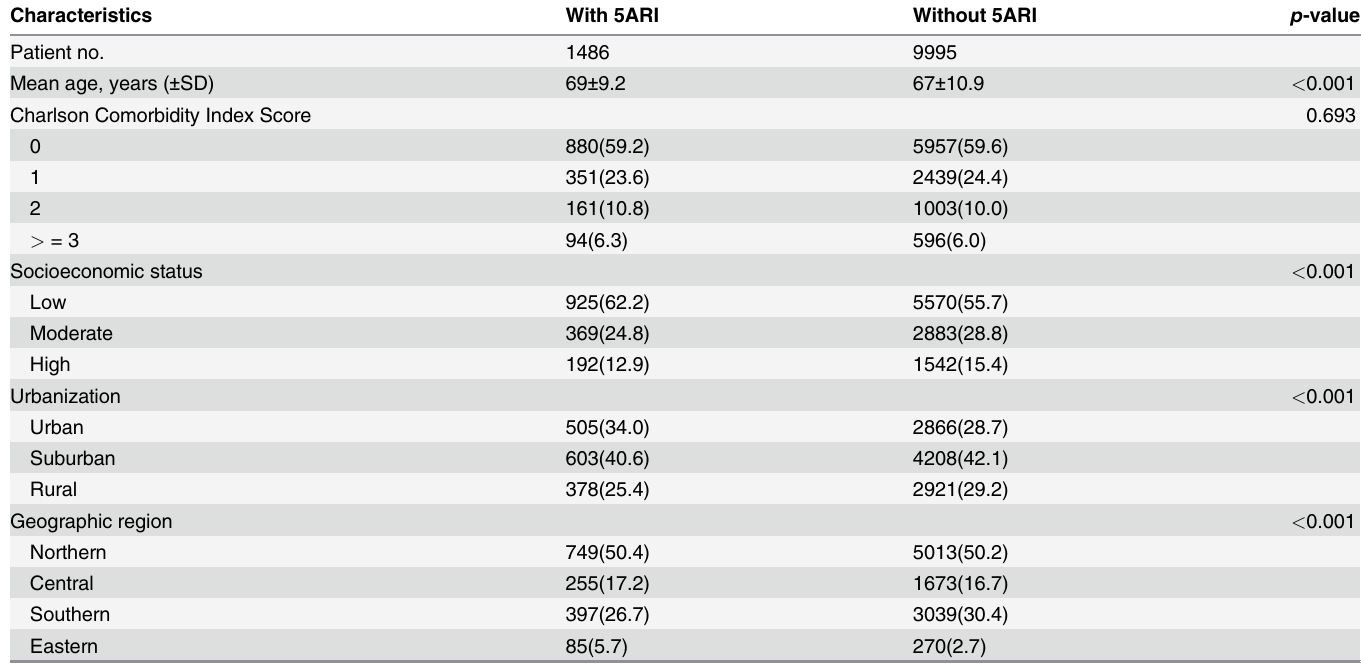
Table 1. Demographic characteristics of the study cohort and controls (n =